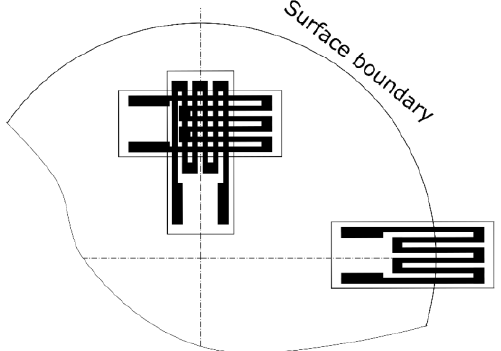
Fig. 5. Possible violations of topological constraints: overlapping of gauges and violation of the boundary of the surface appointed for mounting